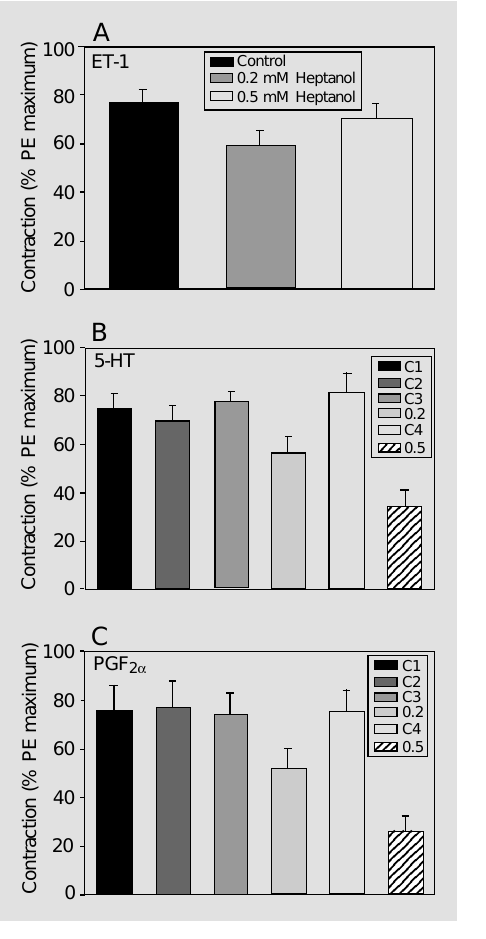
Table 1 - Effects of heptanol on the steady-state magnitude of the PGF 2 a -, 5-HT- and ET-1-induced contractile responses in equivalently contracted isolated rat aortic rings. The time-dependent control values, that is, the response of rat aortic rings to two successive applications of agonist were: 76 ± 10% (N = 16) and 77 ± 11% for PGF 2 a , and 75 ± 6% (N = 25) and 70 ± 6% for 5-HT. Note that two successive applications were not possible for ET-1; see Material and Methods. * P<0.05 compared to control (Fischer’s PLSD post hoc analysis). For abbreviations, see legend to Figure 1. Drug Control 0.2 mM